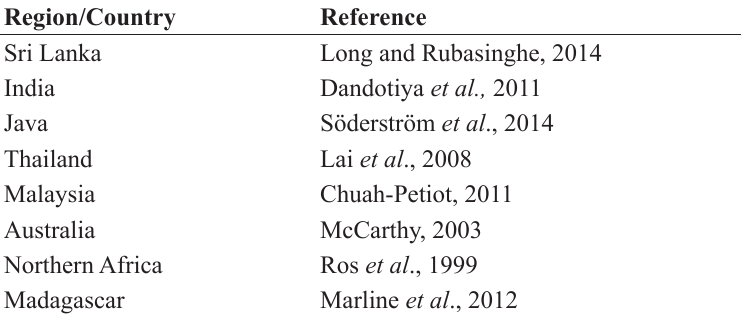
Table 2: Shared taxa of liverworts and hornworts as a percentage.